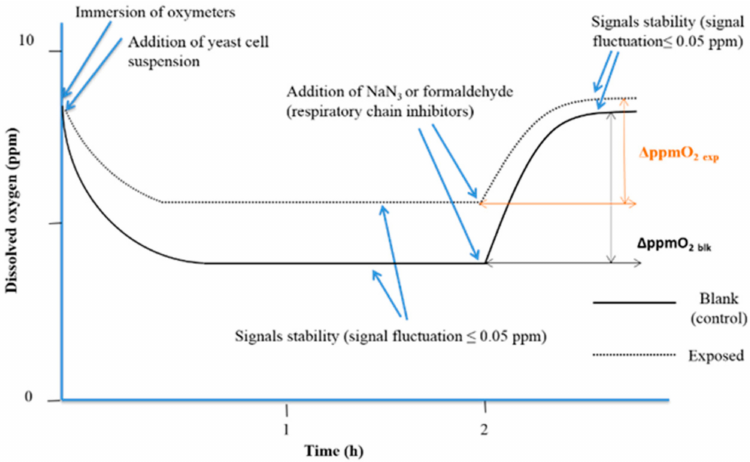
Figure 2. The experimental respirometric curve shows the dissolved oxygen (ppm O 2 ) vs. time (adapted from Dragone et al., 2015